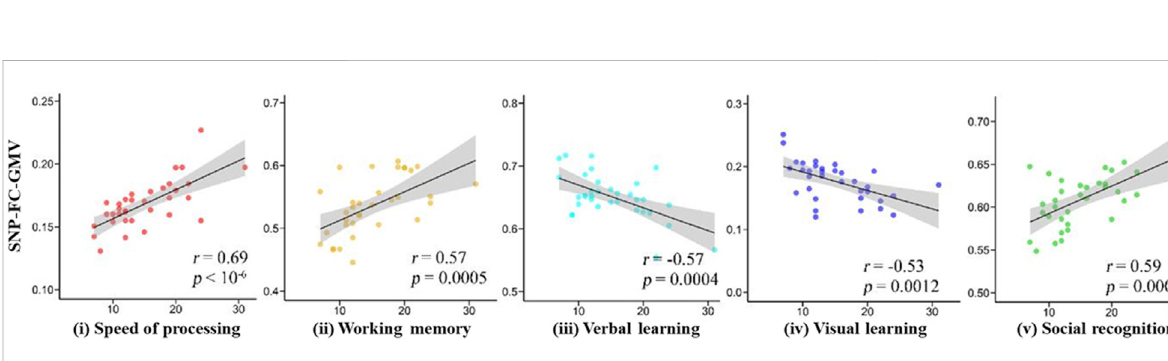
the left temporal lobe and bilateral hippocampus. Follow-up region-of-interest analyses of brain regions with aberrant gFCD in the SCZ group demonstrated that basal ganglia FC